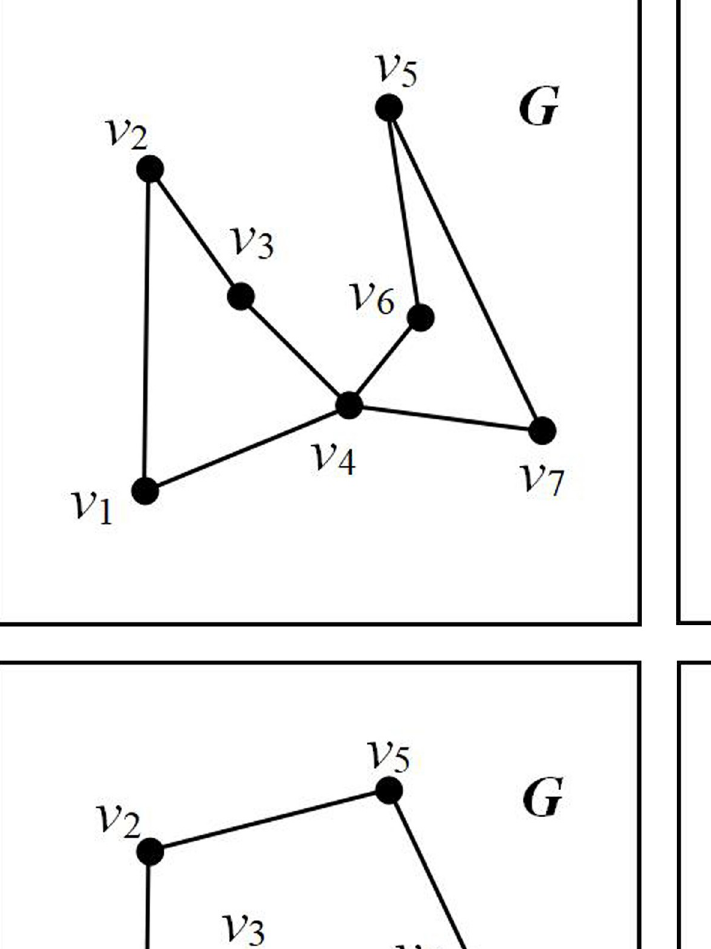
PLOS ONE | https://doi.org/10.1371/journal.pone.0230342 March 13,